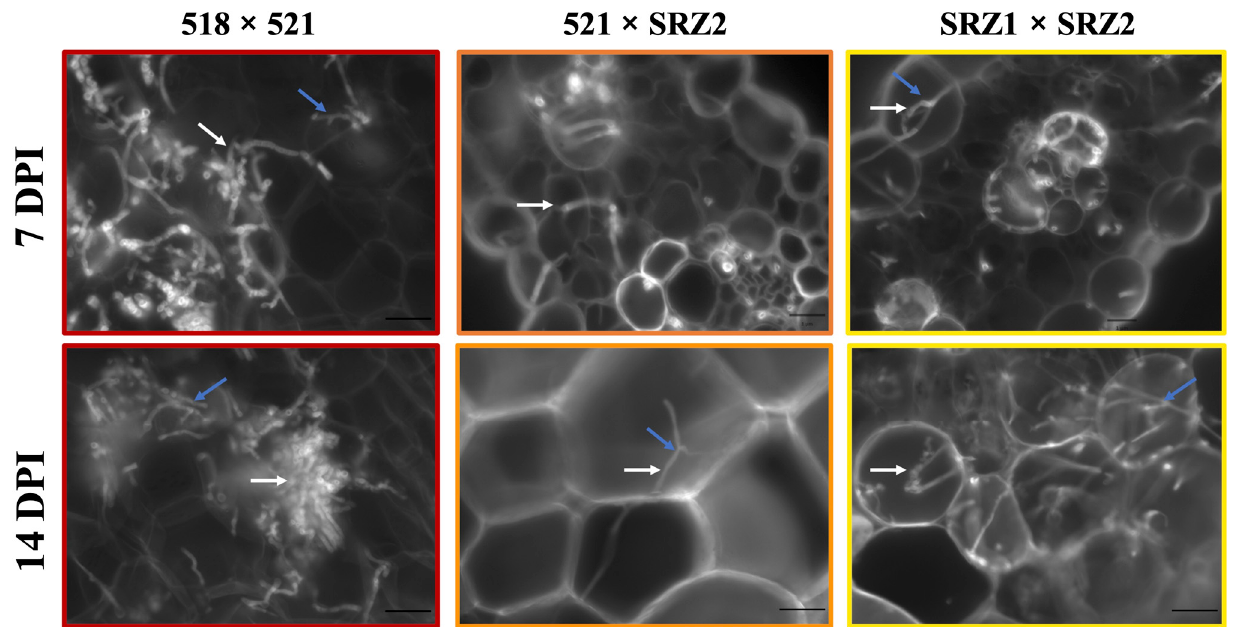
Figure 3. Hyphal growth of 521 × SRZ2 was low compared to 518 × 521 and SRZ1 × SRZ2 at 7 and 14 DPI. Representative cross sections of infected Z. mays tissue stained with Fungi-Fluor and viewed under Zeiss microscope at 400 × . White arrows indicate hyphal growth through plant cells and blue arrows indicate hyphal branching. Scale bar, 20 μ m.